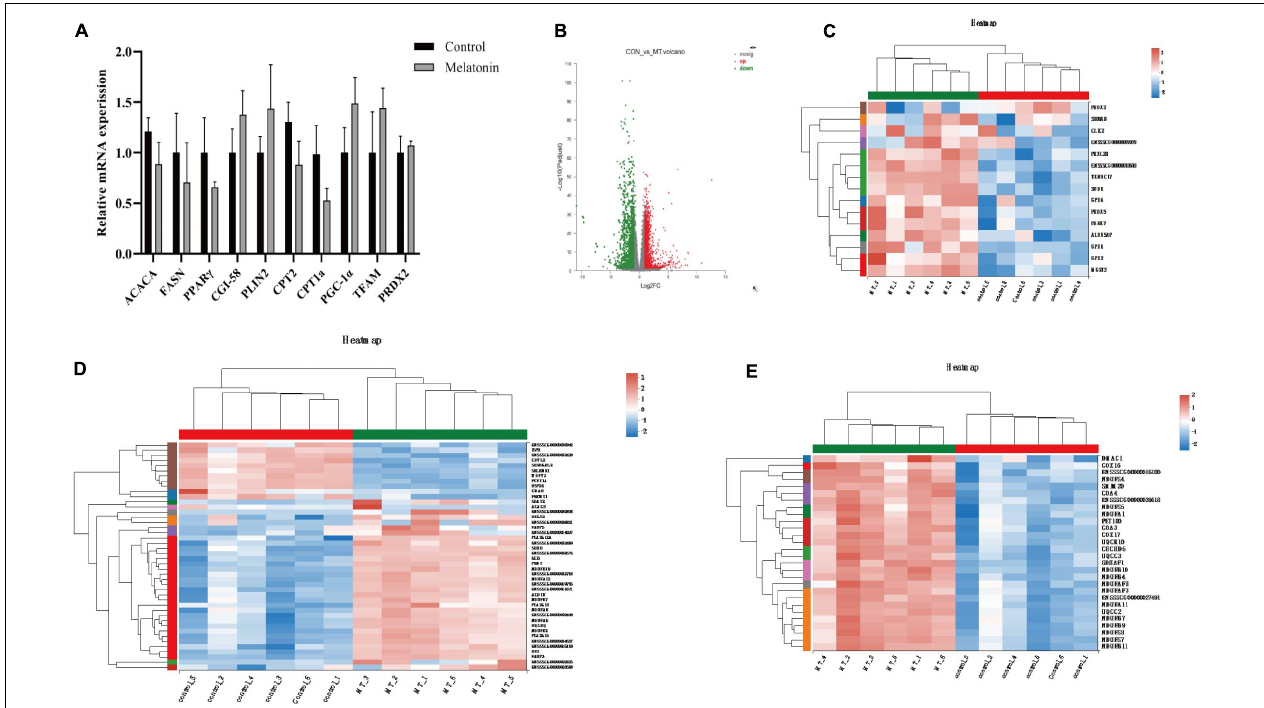
FIGURE 7 | Melatonin affects the gene expression in cumulus cells. (A) The mRNA levels of lipid metabolism and mitochondrial biosynthesis in porcine granulosa cells. Different lowercase letters indicate significant differences. Error bars indicate SEM. (B) The volcano plot showing upregulated (red) and downregulated (green) gene cumulus cells of the control and melatonin groups. (C–E) Heatmap showing average expression for all replicates and relative expression between replicates for genes with antioxidants, lipid metabolism, and mitochondrial respiration chain (based on GO